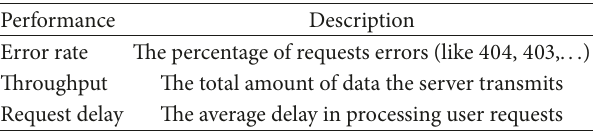
Table 2: Performance and description on data set A.